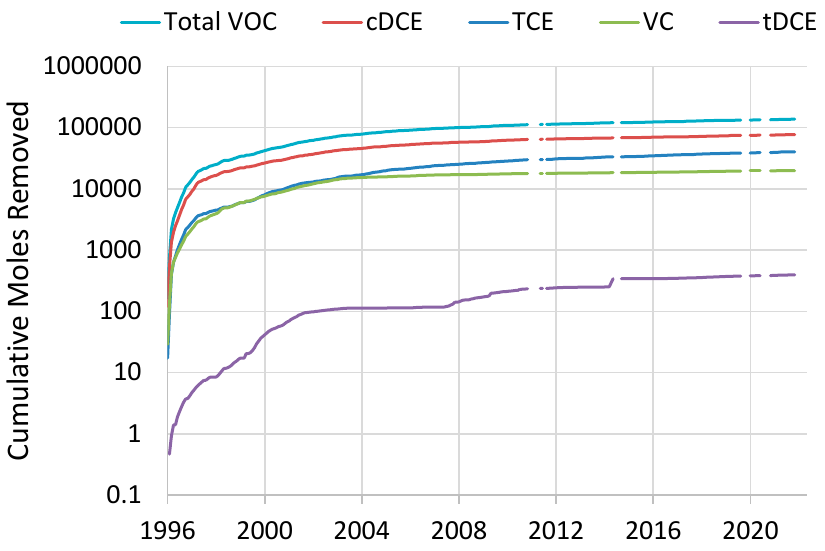
Figure 7. Cumulative moles of individual and total CVOC removed from NAWC by PAT from 1996 to 2021. Data from 1995 to 2010 were taken from Lacombe [66], data from 2011 to 2020 were provided by the U.S. Navy, and later data from 2020 to 2021 were taken from U.S. EPA’s monthly summary reports.